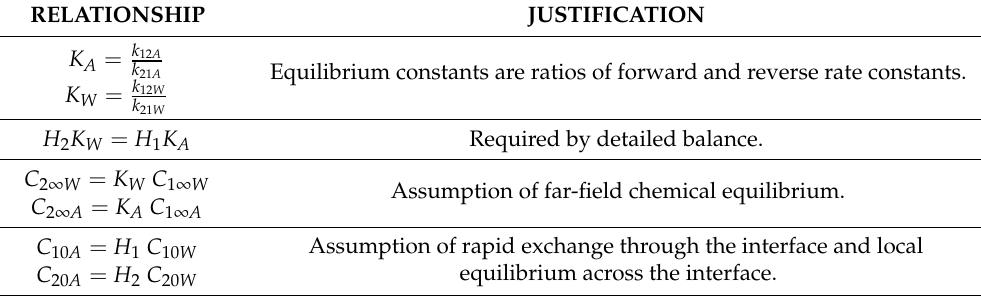
Assumption of rapid exchange through the interface and local equilibrium across the interface. C 20 A = H 2 C 20